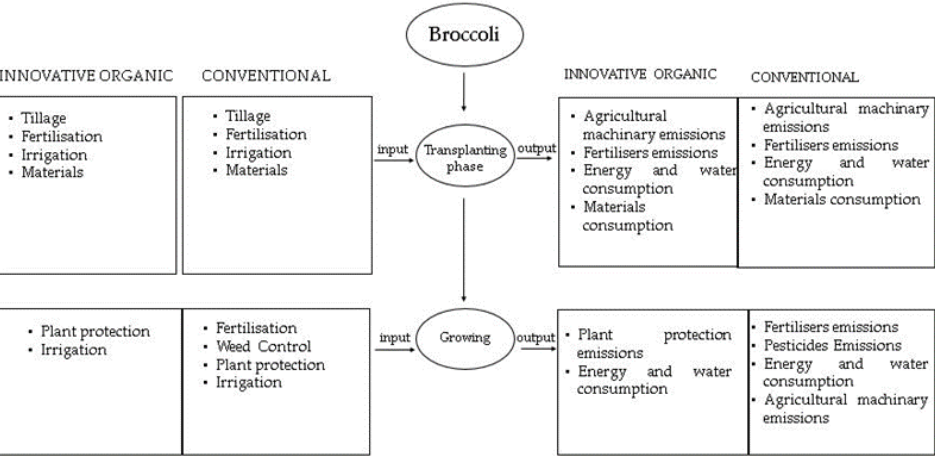
Figure 1. System boundary in the evaluation of broccoli LCA. (*). (*) Our elaboration.